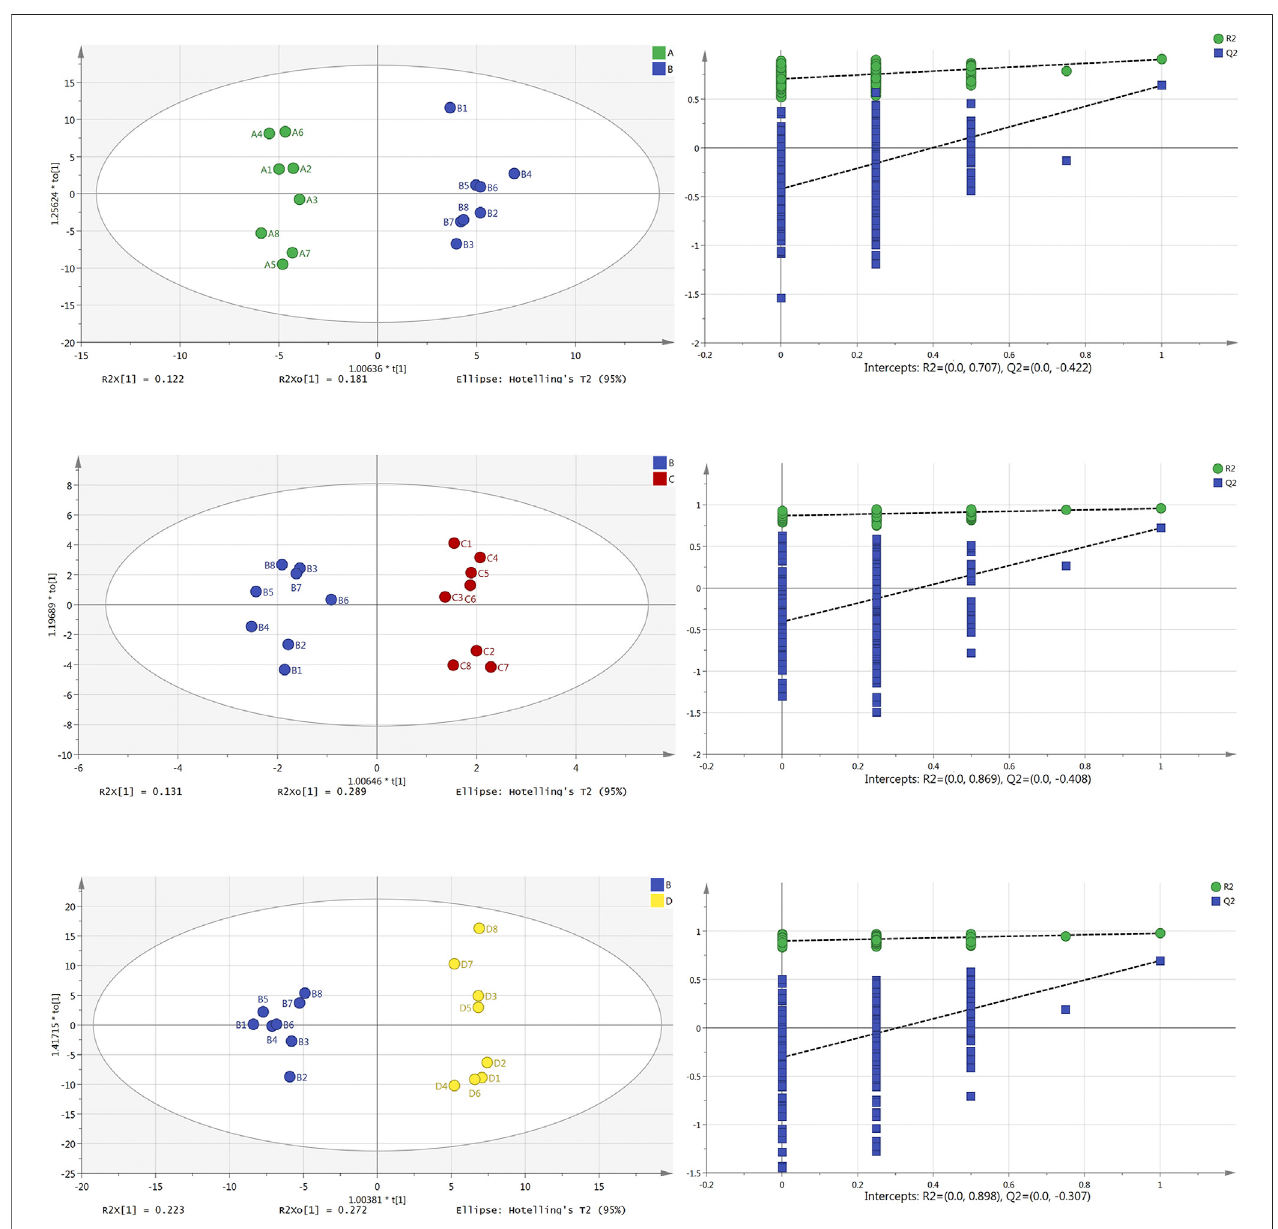
FIGURE 4 | OPLS-DA scores plot and permutation test diagram of normal group (A), model group (B), Borneol essential oil group (C), and reference group (D) in brain tissue samples ( n = 8).